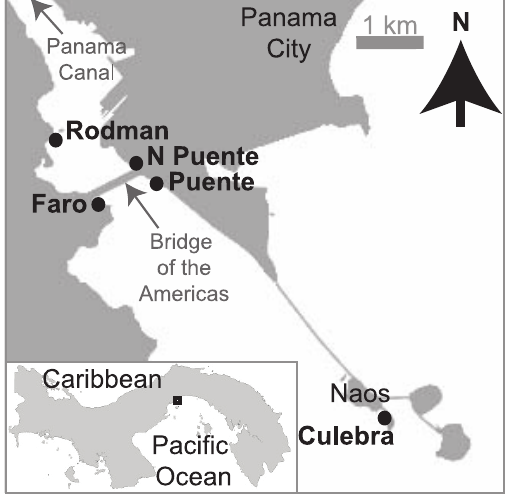
Figure 1. Study area. Location of study sites near the Pacific entrance to the Panama Canal in the Bay of Panama. Land is represented by gray shading and water is shown in white.